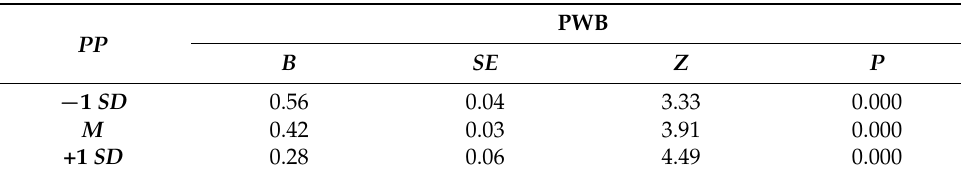
Table 4. Index of mediated moderation.